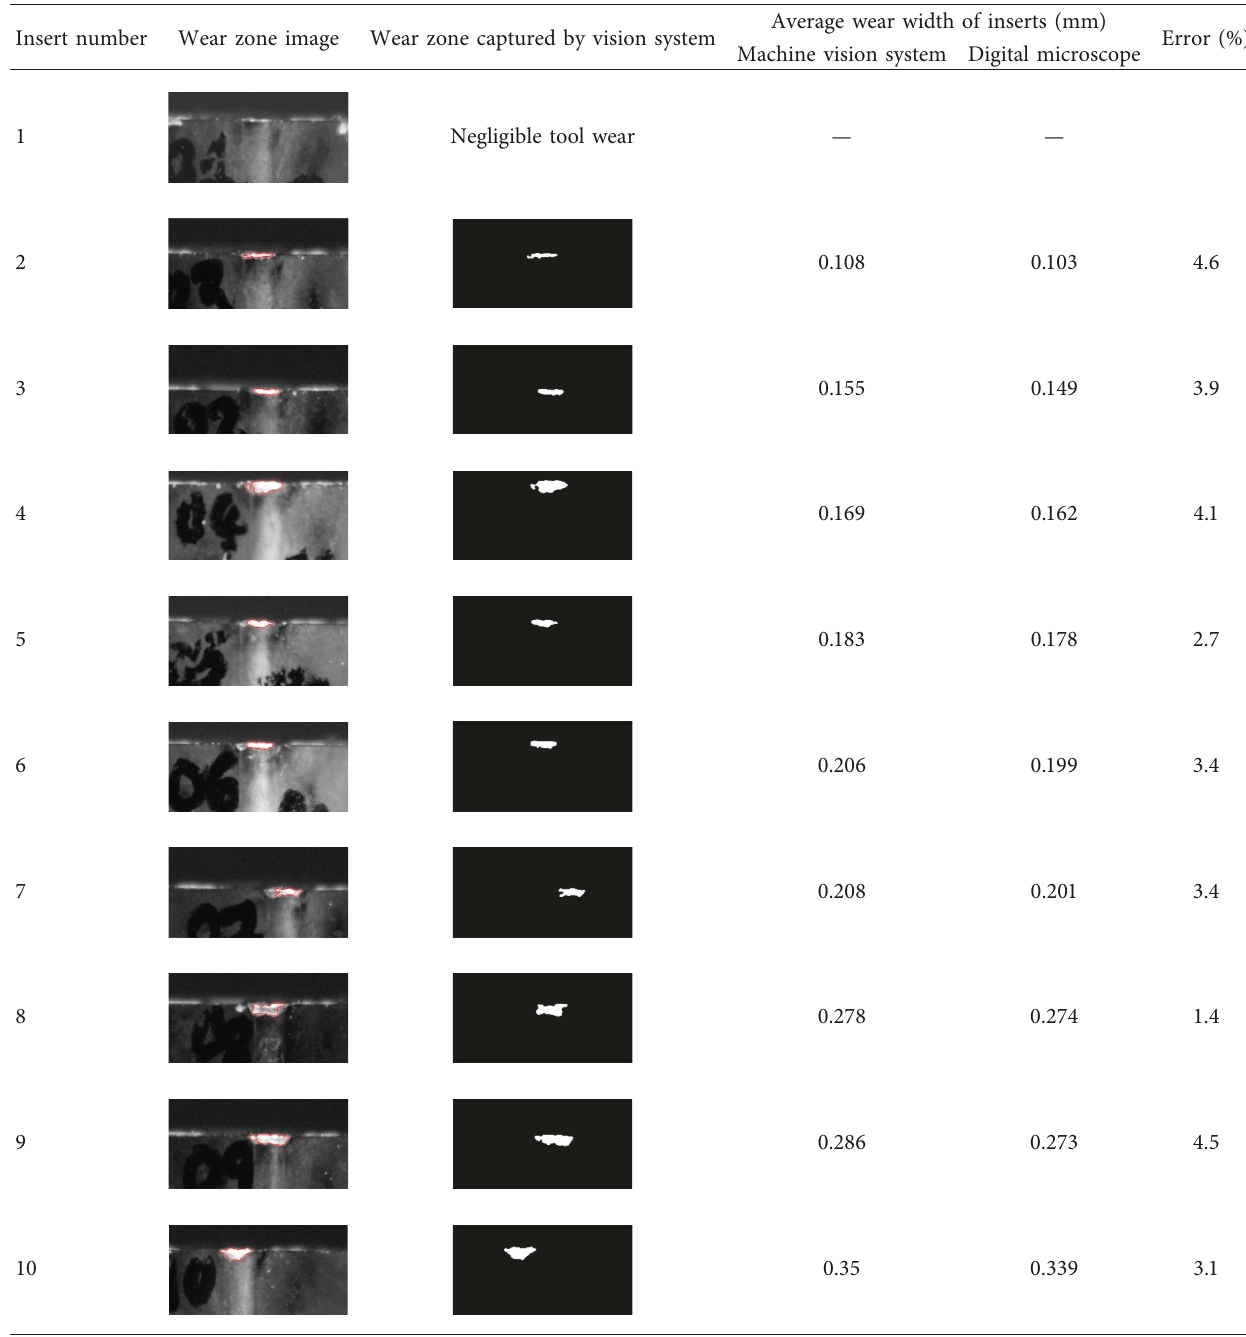
Table 3: Comparison between the average wear width measured by the vision system and the digital microscope.